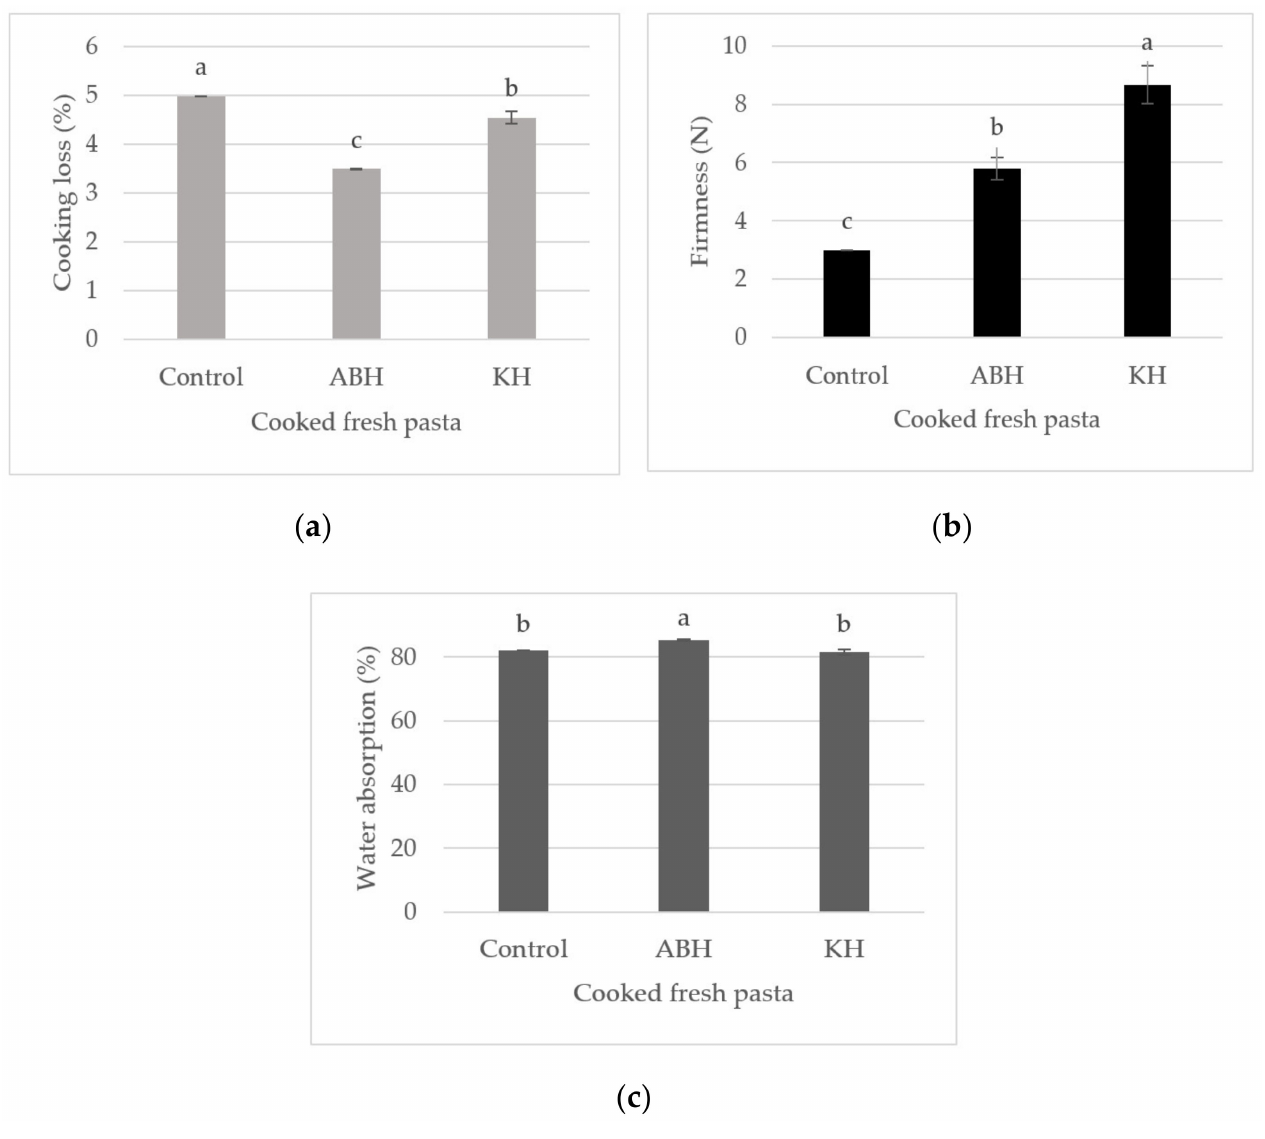
Figure 2. Cooking loss ( a ), firmness ( b ), and water absorption ( c ) of cooked GF fresh pasta enriched with 8 g/100 g of Apulian black (ABH) or kabuli (KH) chickpea hull, compared to control pasta. Different letters indicate significant differences at p <